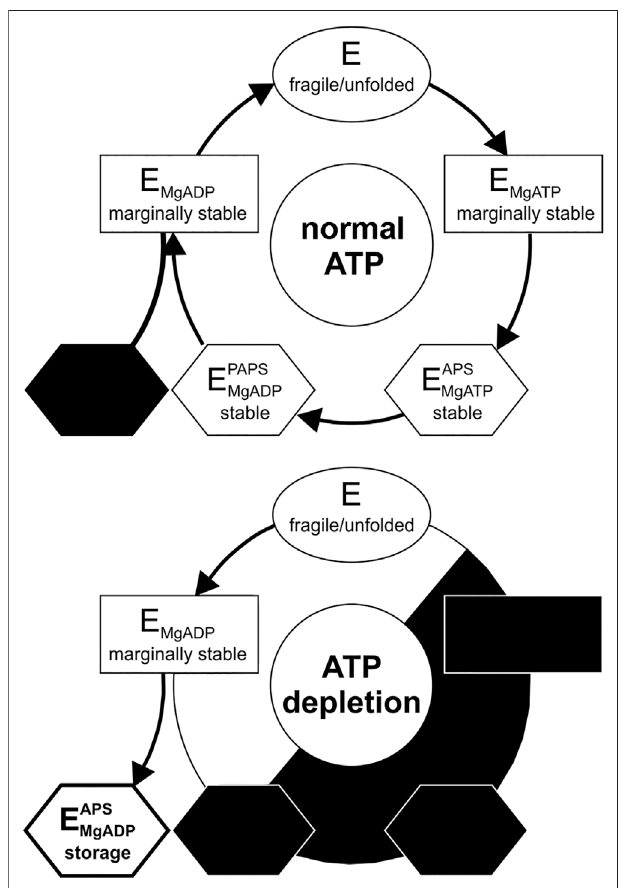
FIGURE 4 | Catalytic and temporal stability cycle of APS kinase from PAPS synthase. (Top) Catalytic cycle of the APS kinase domain of PAPS synthases at physiological ATP concentrations. The storage form (ADP-APS complex) is most likely not signi fi cantly utilized under these conditions (blacked out) (Bottom) Distribution of the states during ATP depletion. Decreasing ATP concentration via starvation or DNA damage results in population of the kinase complexes within the cycle with the least phosphorylation equivalents of the substrates. The storage form of the PAPS intermediate APS and ADP may serve as a stable state for a fraction of the APS kinase protein ensemble in times of ATP